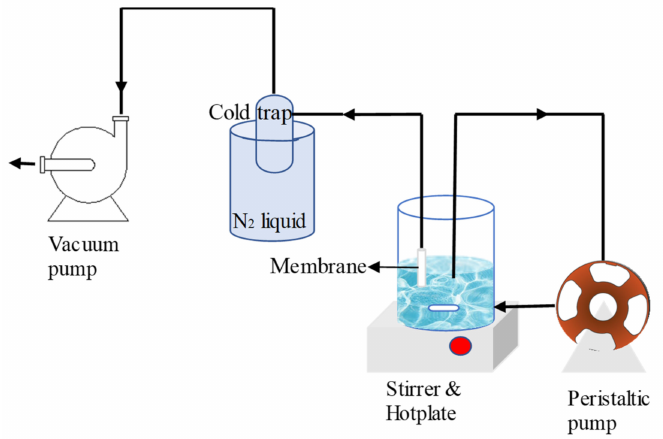
Figure 2. Membrane desalination using a customised pervaporation